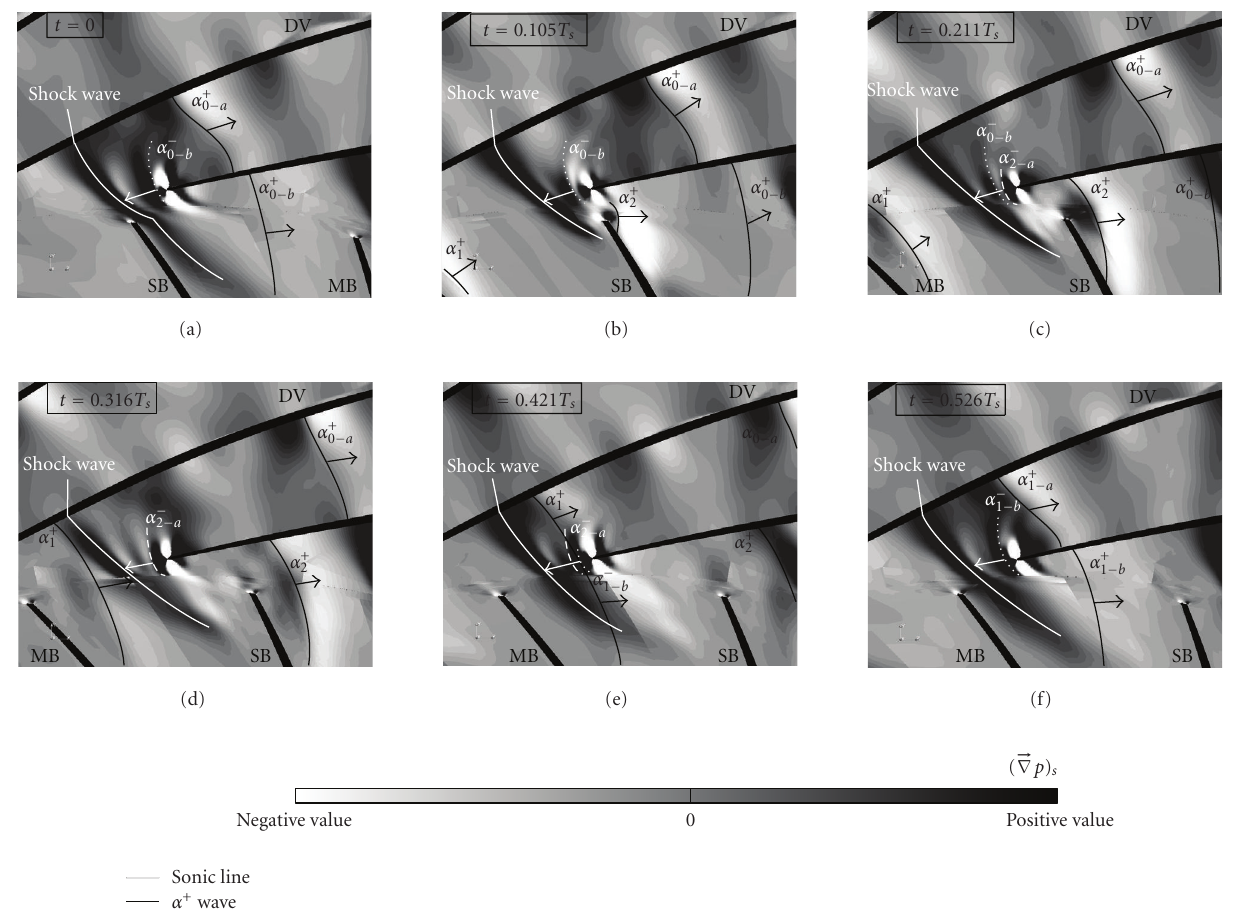
Figure 10: Generation of pressure waves at six time